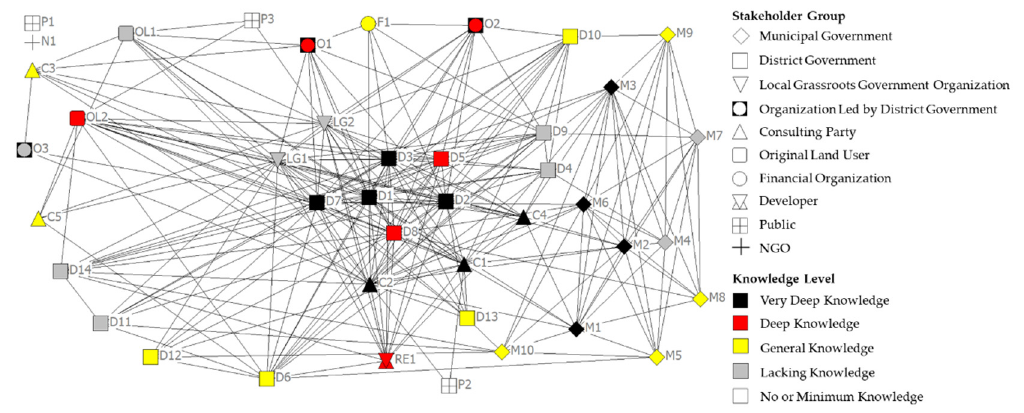
Figure 4. Interaction network, grouped based on ( a ) stakeholder group and type of interest, ( b ) stakeholder group and knowledge level.